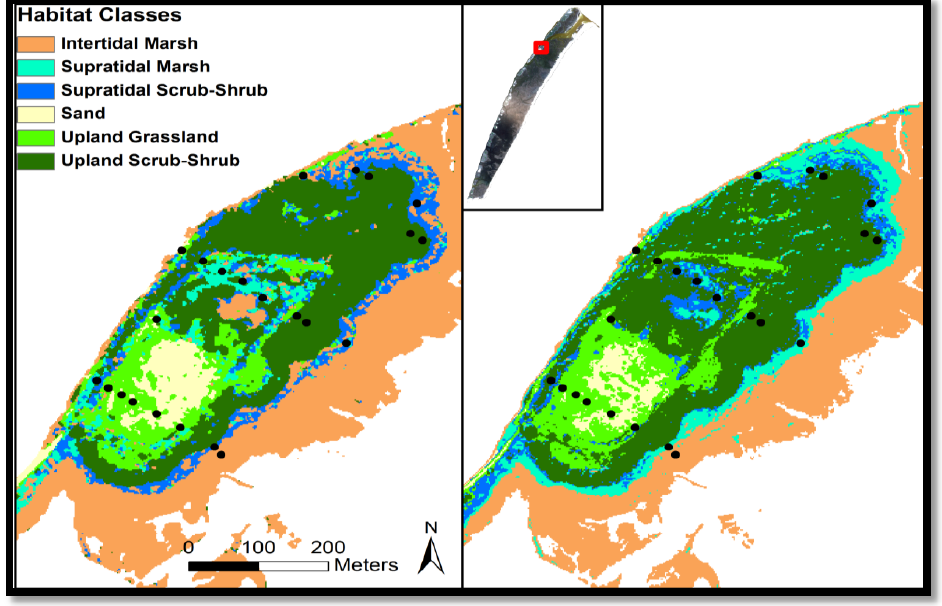
Figure 4. Supervised and unsupervised classification maps for an example spoil island. On the left is WV-2 supervised, non-sharpened, 8 bands, majority filtered (72.56% accurate) and on the right is WV-2 unsupervised, non-sharpened, 8 bands, majority filtered (64.01% accurate).